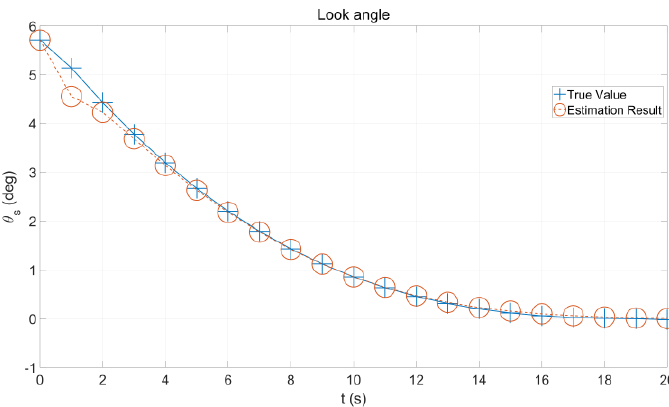
Figure 10. Trajectory of the flight path angle and corresponding estimates.